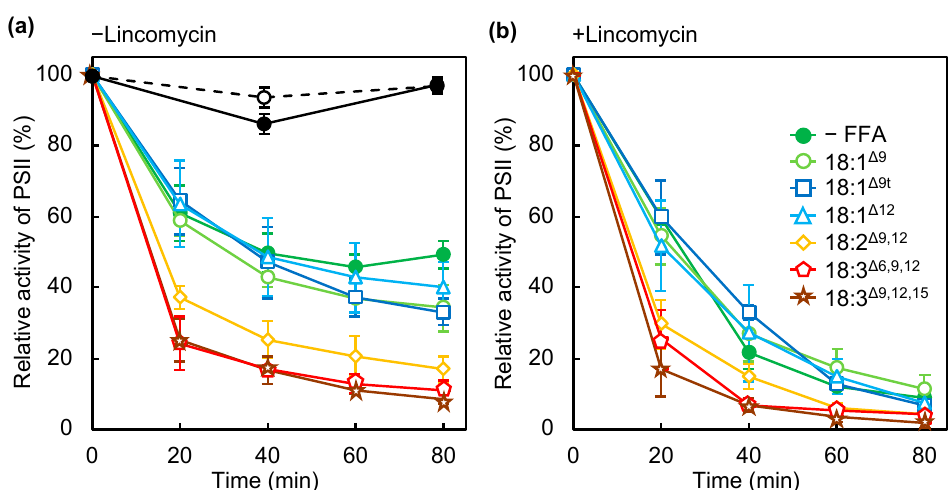
Figure 1. Effect of several C18 free fatty acids (FFAs) on the photoinhibition of PSII. Wild-type cells were incubated in the absence (filled green circles) or presence of oleic acid (18:1 Δ 9 ; light green circles), elaidic acid (18:1 Δ 9t ; blue squares), cis -12- octadecenoic acids (18:1 Δ 12 ; light blue triangles), linoleic acid (18:2 Δ 9,12 ; yellow rhombuses), γ -linolenic acid (18:3 Δ 6,9,12 ; red pentagons), or α -linolenic acid (18:3 Δ 9,12,15 ; brown stars) at 32 °C under strong light at 1500 μ mol photons m − 2 s − 1 under ambient aeration without ( a ) and with ( b ) lincomycin. Changes in PSII activity under weak light at 70 μ mol photons m − 2 s − 1 under ambient aeration in the absence (empty circles) or presence (filled circles) of α -linolenic acid (18:3 Δ 9,12,15 ) are also shown in ( a ). FFAs were supplemented at a final concentration of 50 μ mol L − 1 just before illumination. The activity of PSII was monitored in terms of the evolution of oxygen in the presence of 1 mmol L − 1 1,4-benzoquinone as the electron acceptor. Values are the means ± SD of three independent experiments.